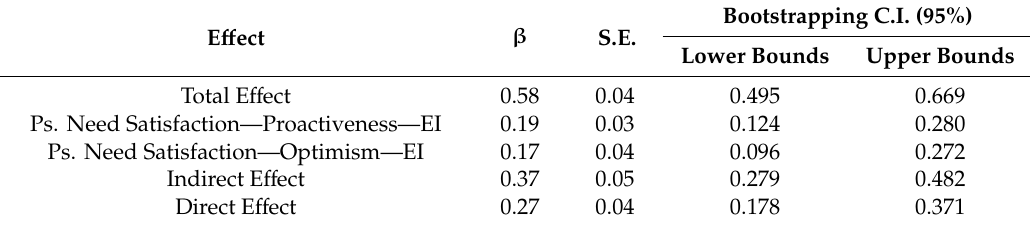
4. Total e ff ect, indirect e ff ect, and direct e ff ect psychological need satisfaction—entrepreneurial intentions. E ff ect β S.E. Total E ff